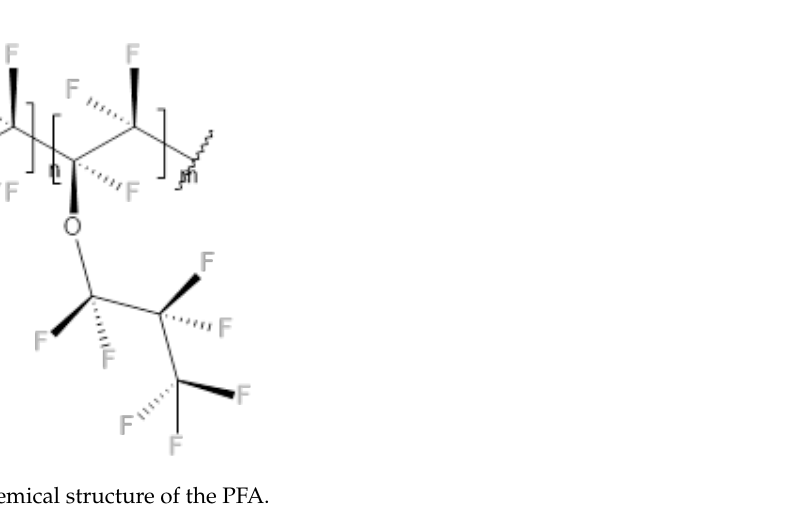
Figure 14. The 4000 – 1400 cm − 1 range of the spectrum relating to unaged and aged PFAs. The behavior of the aged PFA can be explained by considering the chemical structure of the polymer, which is schematically represented in Figure 15. Indeed, the ether group can be attacked during the aging process and COOH groups can be introduced [12].